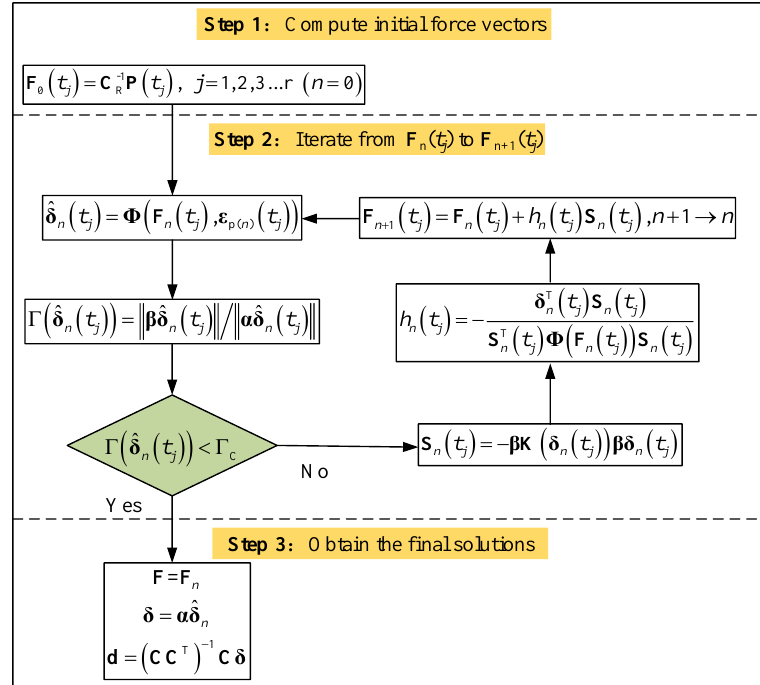
Figure 1. Computational procedure of LIM for elastoplastic problems.